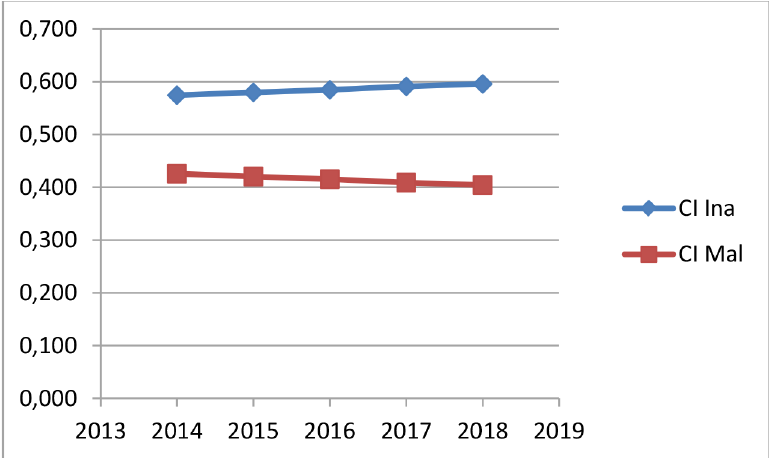
Figure 12. Model Output: Competitiveness Index of Indonesia and